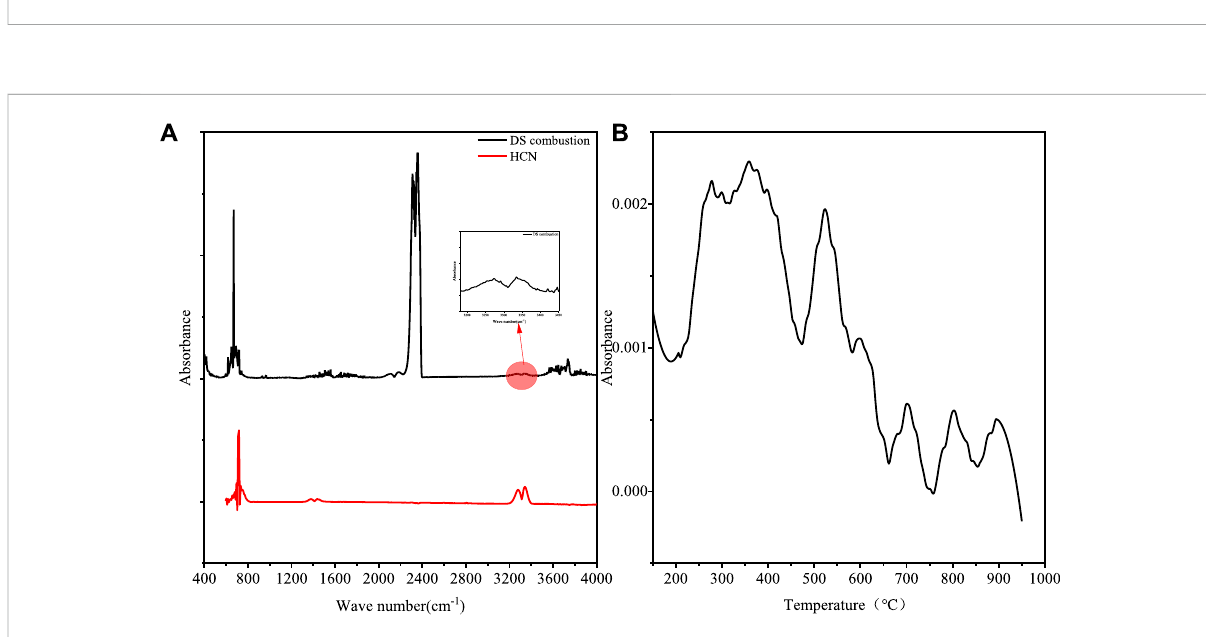
FIGURE 4 (A) The spectrum of gaseous products from DS combustion 400 ° C and HCN; (B) the release curves of DS combustion at 3342 cm − 1 wave number absorption with